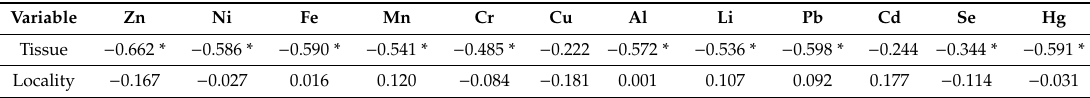
Table 5. Pearson correlations between the metal concentrations and snail tissue and sampling localities, respectively. * p ≤